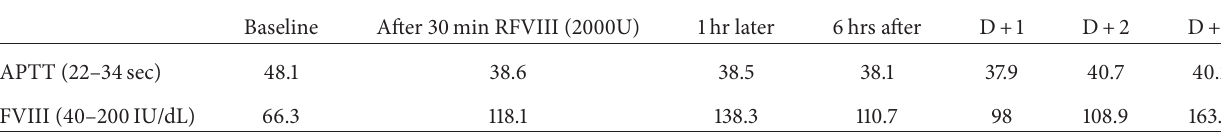
Table 1: Perioperative APTT and FVIII